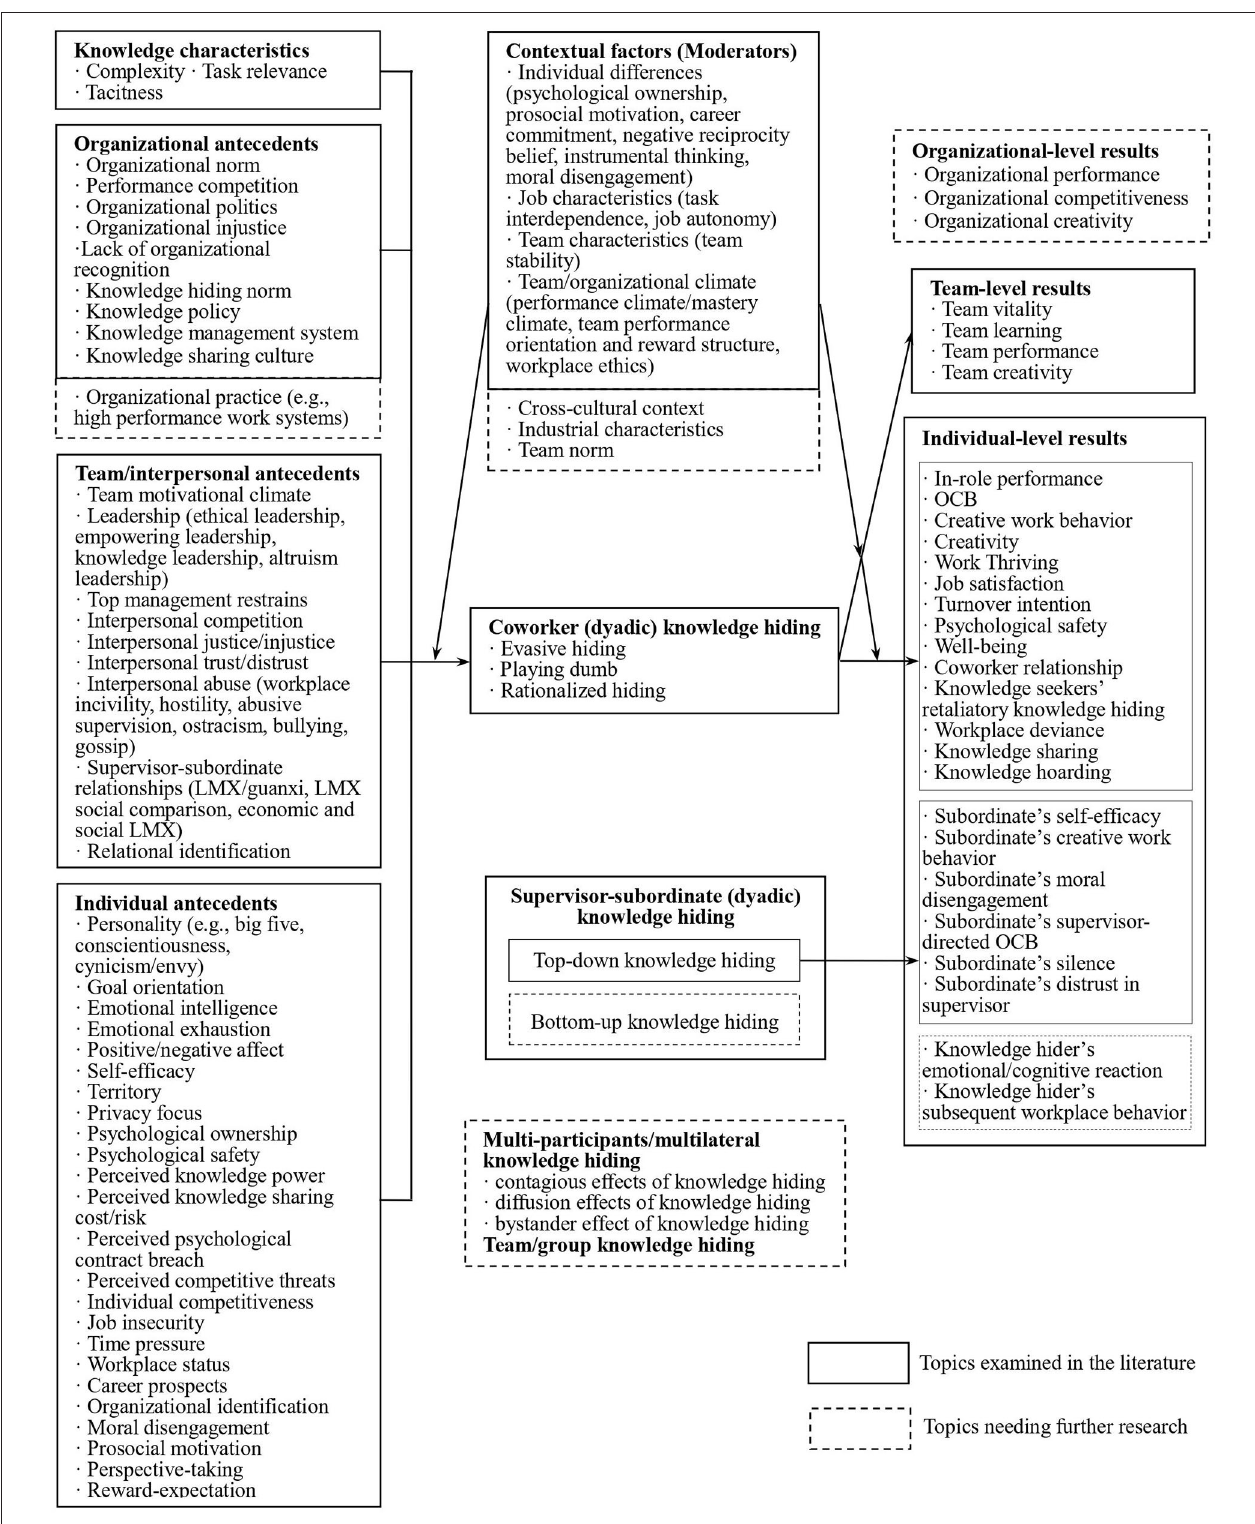
FIGURE 3 | Research framework of knowledge hiding. Source: extended and developed from Connelly et al. (2012) and Xiao and Cooke (2019).